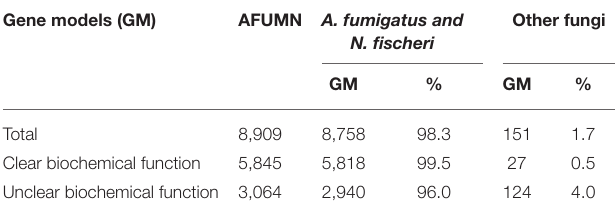
Consult Table S2 for itemized list of AFUMN gene